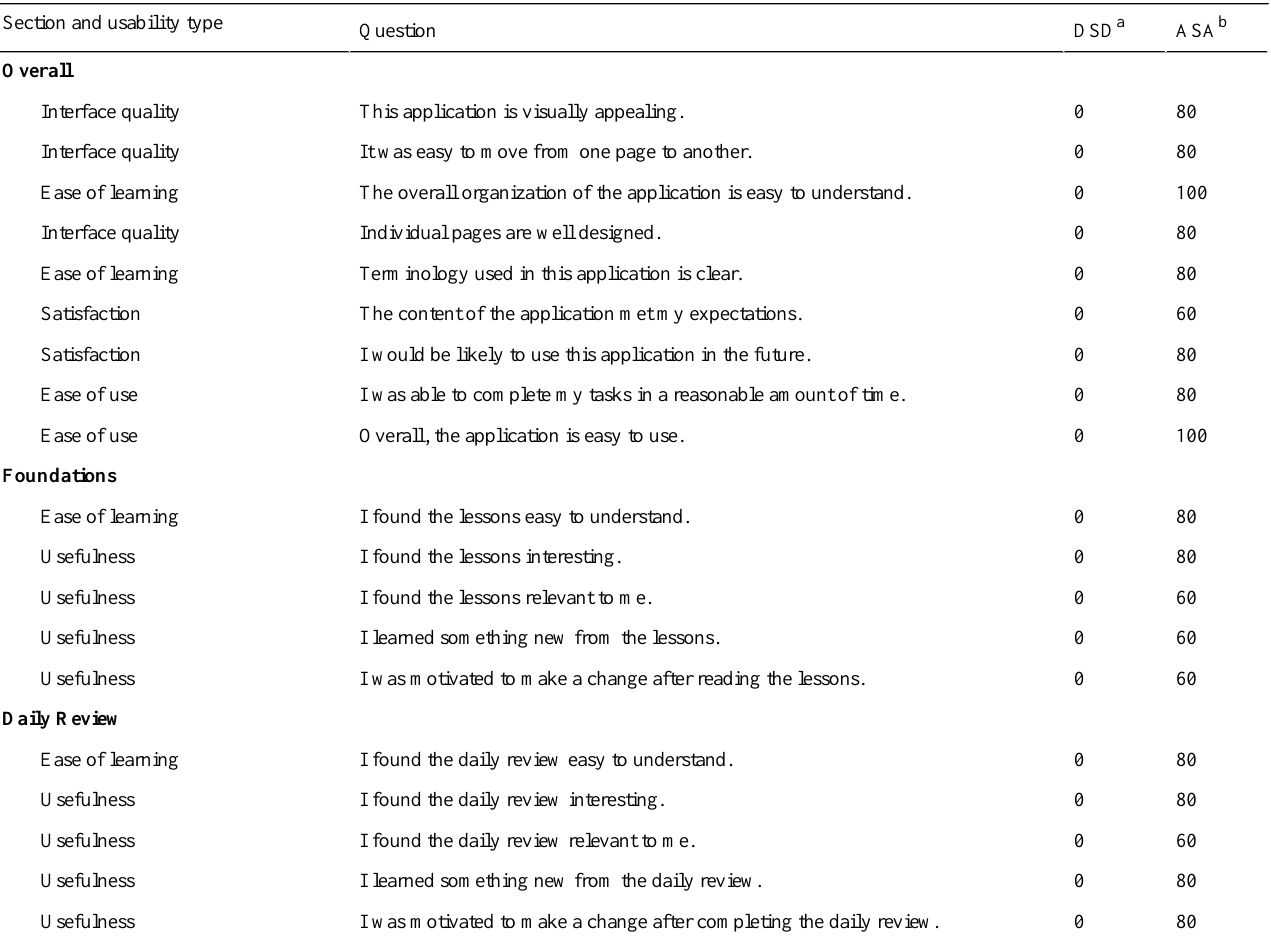
Table 3. Usability testing: posttask questionnaire